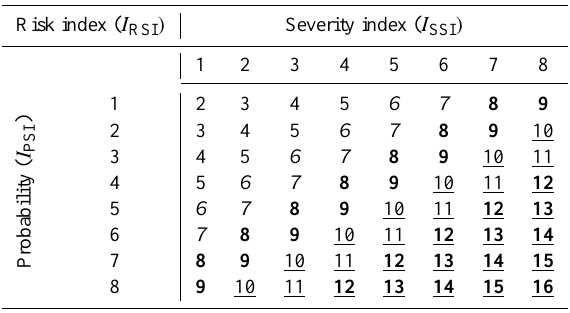
Table 2. Risk matrix based on probability and severity indices, with corresponding representation with colour. 2< I RSI ≤ 5 (nor- mal text): dark green – very low or insignificant risk; 6 ≤ I RSI ≤ 7 (italic text): light green – low or minor risk; 8 ≤ I RSI ≤ 9 (bold text): yellow – medium or moderate; 10 ≤ I RSI ≤ 11 (underline text): orange – high level or serious; 12 ≤ I RSI < 16 (underline + bold text): red – very high or